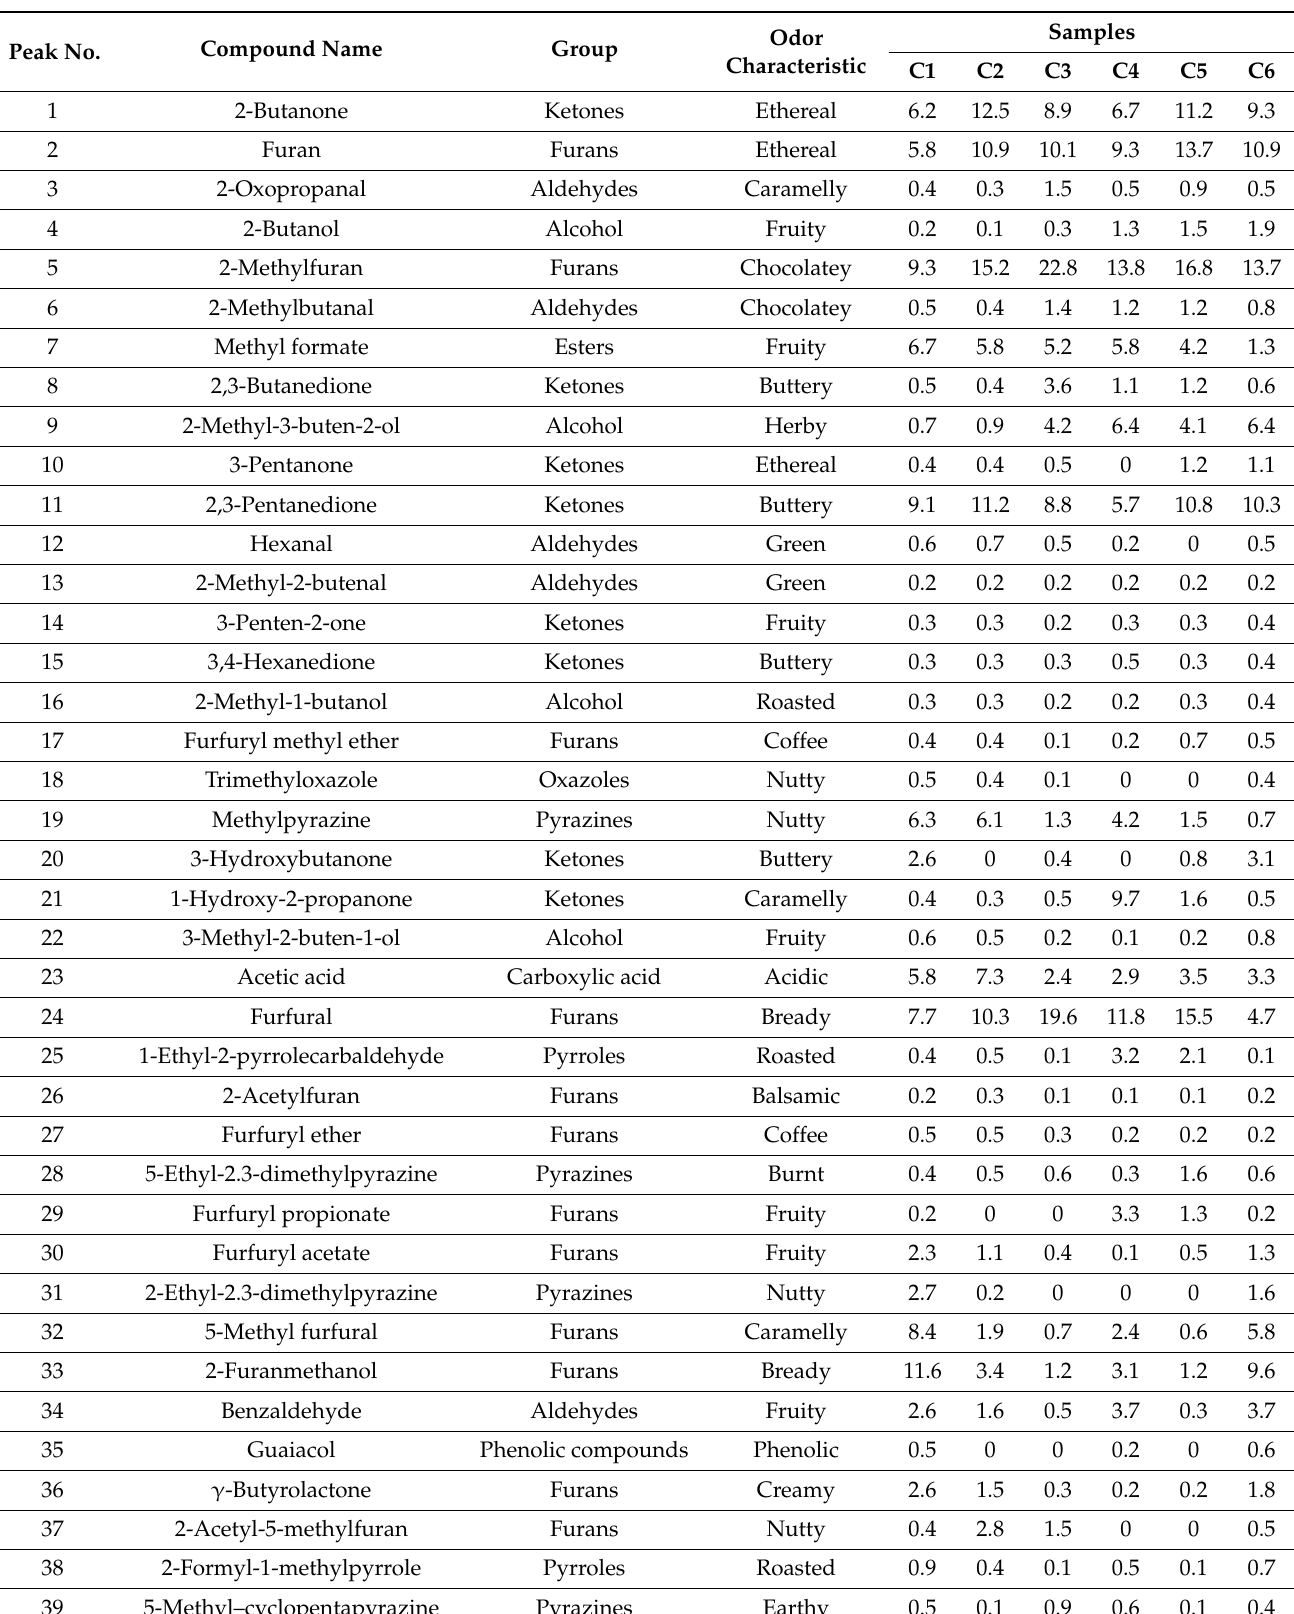
Table 1. Volatile organic compound contents (%) identified by HS-SPME